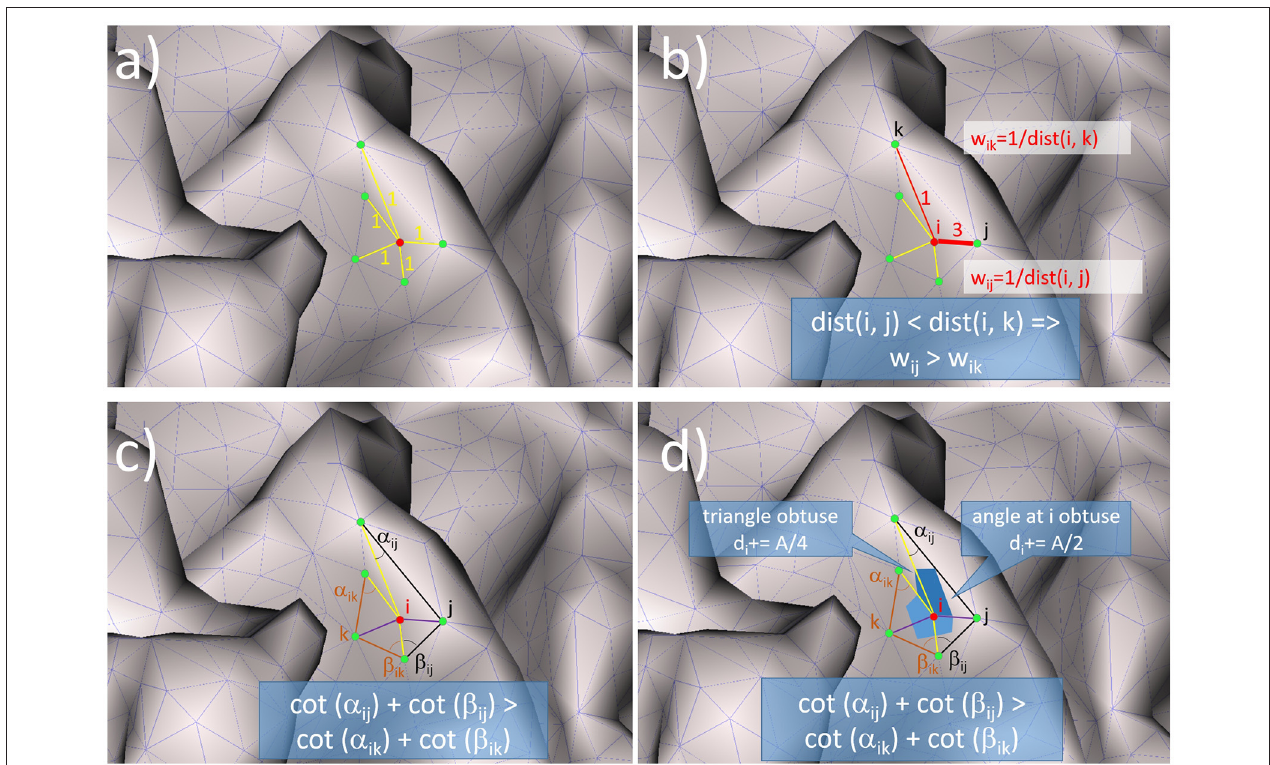
FIGURE 1 | Illustration of the mode of functioning for: (a) the unweighted graph Laplacian, (b) the weighted graph Laplacian, (c) the unweighted geometric Laplacian, (d) the geometric Laplacian with mixed area weights.